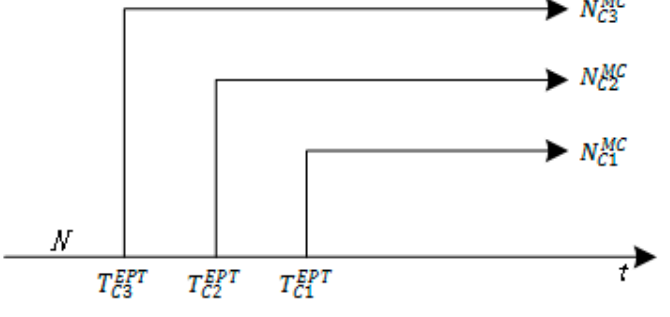
Figure 4. The Logical Structure Model over Time.